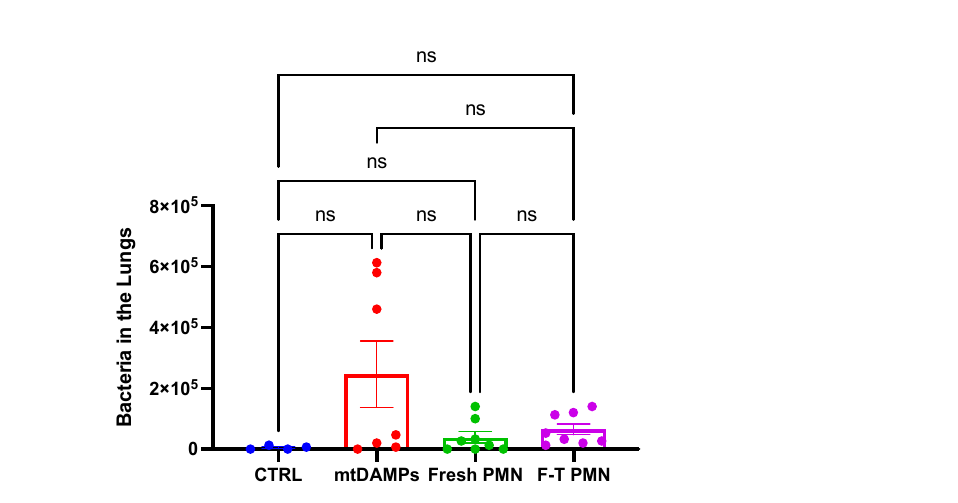
Figure 6. Reactive oxygen species production by freeze–thaw PMN. Freeze–thaw human PMN were loaded with Luminor and 100 nM fMLF (red), PMA (green), or bu ff er (blue) were applied to stimu- late PMN to produce reactive oxygen species (ROS). Real time ROS production is shown in ( A ). Area under curve (AUC) for 5200 seconds was calculated to compare the ROS production ( B ). Experi- ments were done in quadruplicates. Mean and SE values are shown. *: denotes a signi fi cant di ff er-